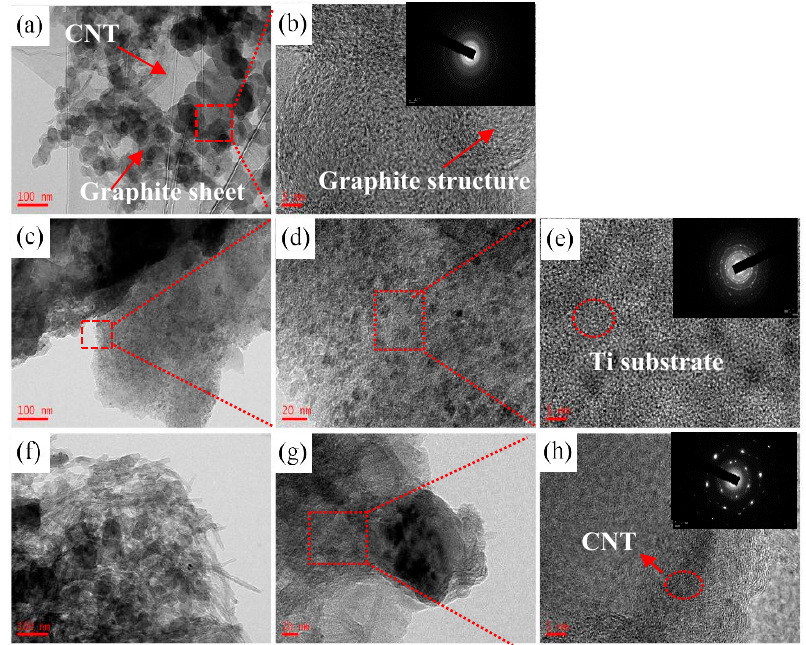
Figure 4. TEM and HRTEM images of the surface morphology ( a , b ) TEM and HRTEM of graphite sheets mixed with carbon nanotubes; ( c – e ) composite coating of carbon, graphite sheet and PTFE; ( f – h ) composite coating of carbon, graphite mixed with carbon nanotubes and PTFE.